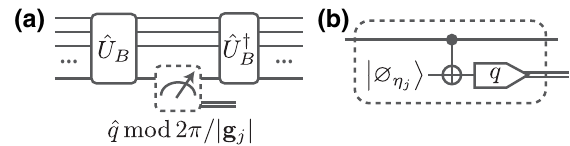
FIG. 6. Steane-type error-correction circuits based on ancilla GKP states. (a) The desired quadrature is mapped to a single- mode on which a modular quadrature measurement is performed. (b) A modular quadrature measurement can be performed by